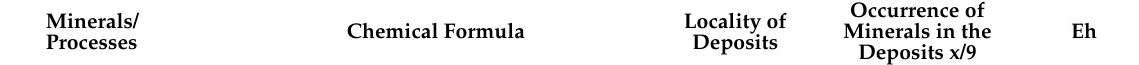
Table 1. Mineral assemblage of Mn and Fe deposits and environmental mineralogical